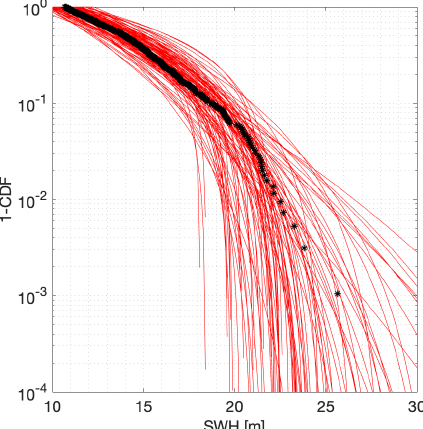
Figure 5. Variability of tail of distributions for STM on log scale. Each of the 100 red lines is estimated from a sample size of 30 of largest STM values from a random sample of 124 cyclones corre- sponding to 200 years of observation. The black points indicate the corresponding empirical distribution of STM from the full synthetic cyclone